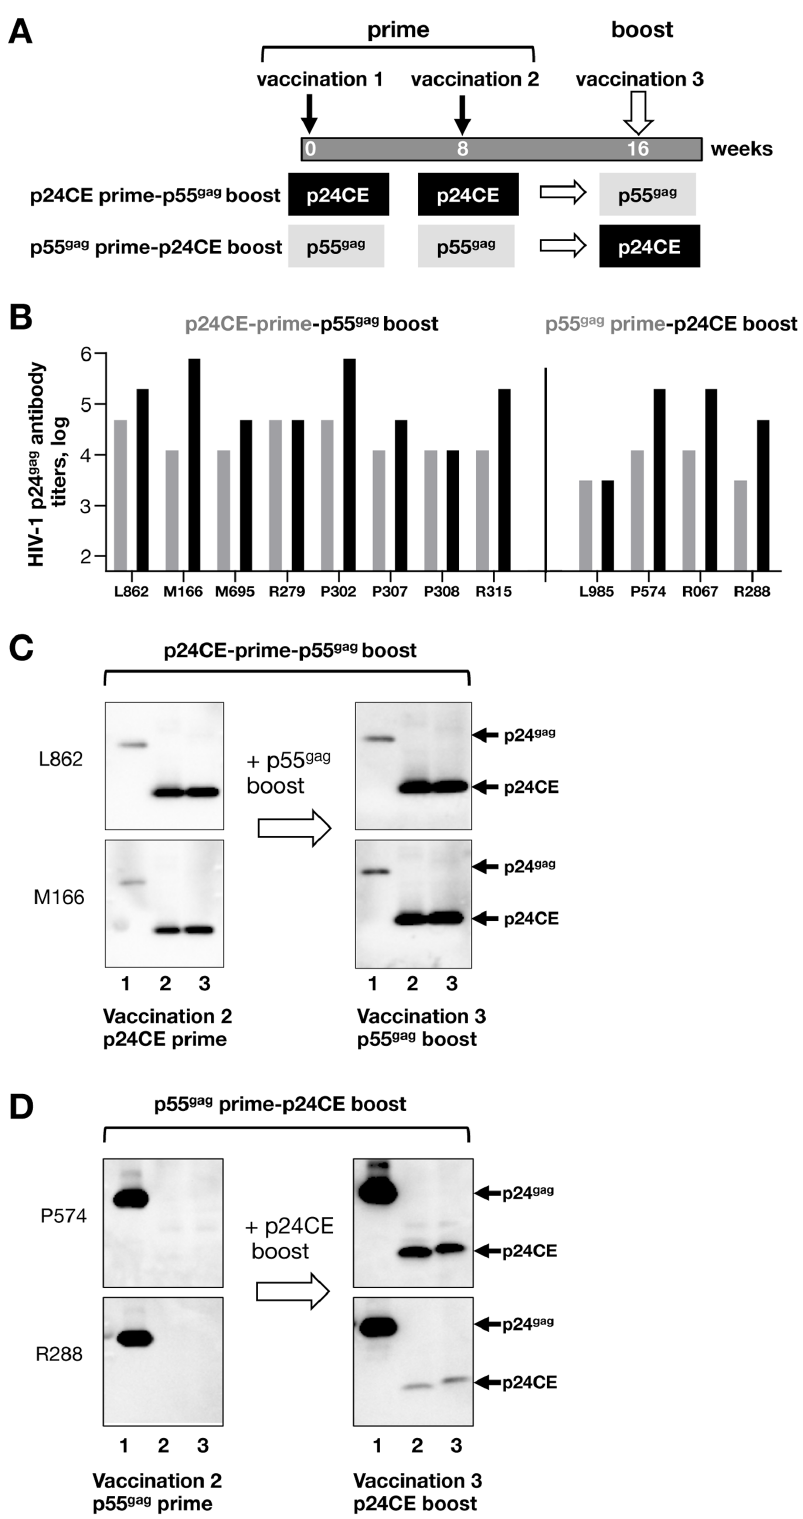
Figure 4. HIV-1 p55 gag DNA vaccination did not prime denovo CE humoral responses but increased pre-existing CE-specific responses. (A) Cartoon depicts the vaccination schedule. After receiving p24CE or p55 gag DNA as priming vaccination (see Figure 2 ) the animals received a heterologous boost vaccination (vaccination 3) with p55 gag DNA or p24CE DNA, respectively. (B) Comparison of plasma bAb to HIV-1 p24 gag ELISA titers at vaccination 3 and 2 weeks later. The reciprocal Gag antibody endpoint titers (in log 10 ) from individual macaques vaccinated with the p24CE DNA mixture following by a p55 Gag DNA boost (N=10; left panel) and macaques vaccinated with p55 Gag DNA followed by a p24CE DNA boost (N=4; right panel) are shown. Data from day of 3 rd vaccination are from Fig. 2B. (C, D) Western immunoblot analysis was used to test